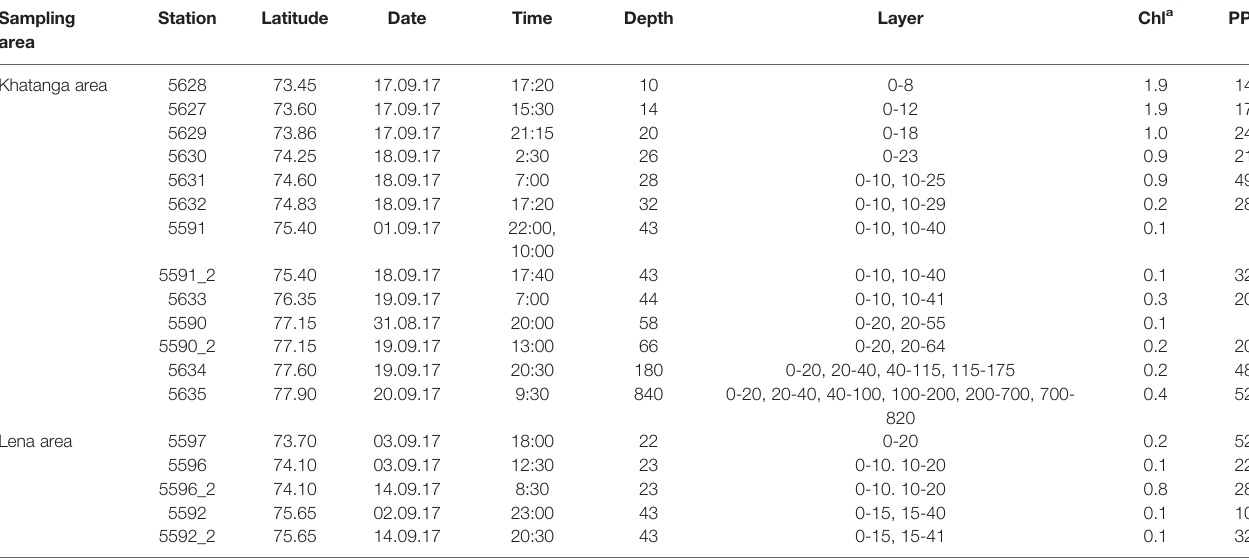
TABLE 1 | Sampling details and environmental characteristics at stations in the Khatanga and Lena areas. Sampling area